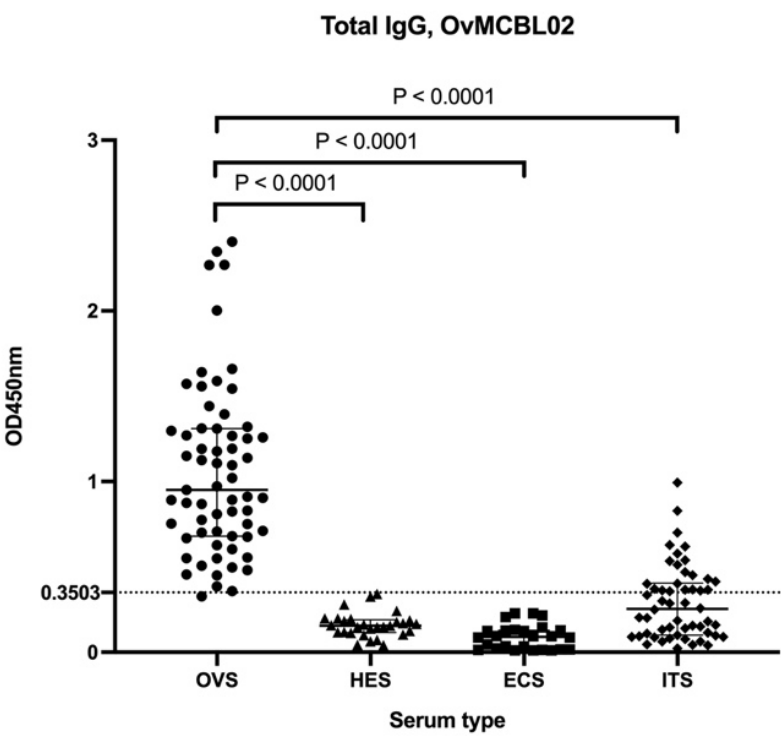
Figure 3. Humoral immune responses to OvMCBL02 multiepitope antigen by ELISA. OVS = O . volvulus serum ( n = 63), HES = Hypo-endemic serum ( n = 29), ECS = European control serum ( n = 26), ITS = Ivermectin treated serum ( n = 54). Kruskal Wallis test followed by Dunn’s test was used for multiple comparisons among the groups. Table 2. Receiver operating curve (ROC) values for IgG responses to OvMCBL02 multiepitope antigen and diagnostic accuracy parameter.